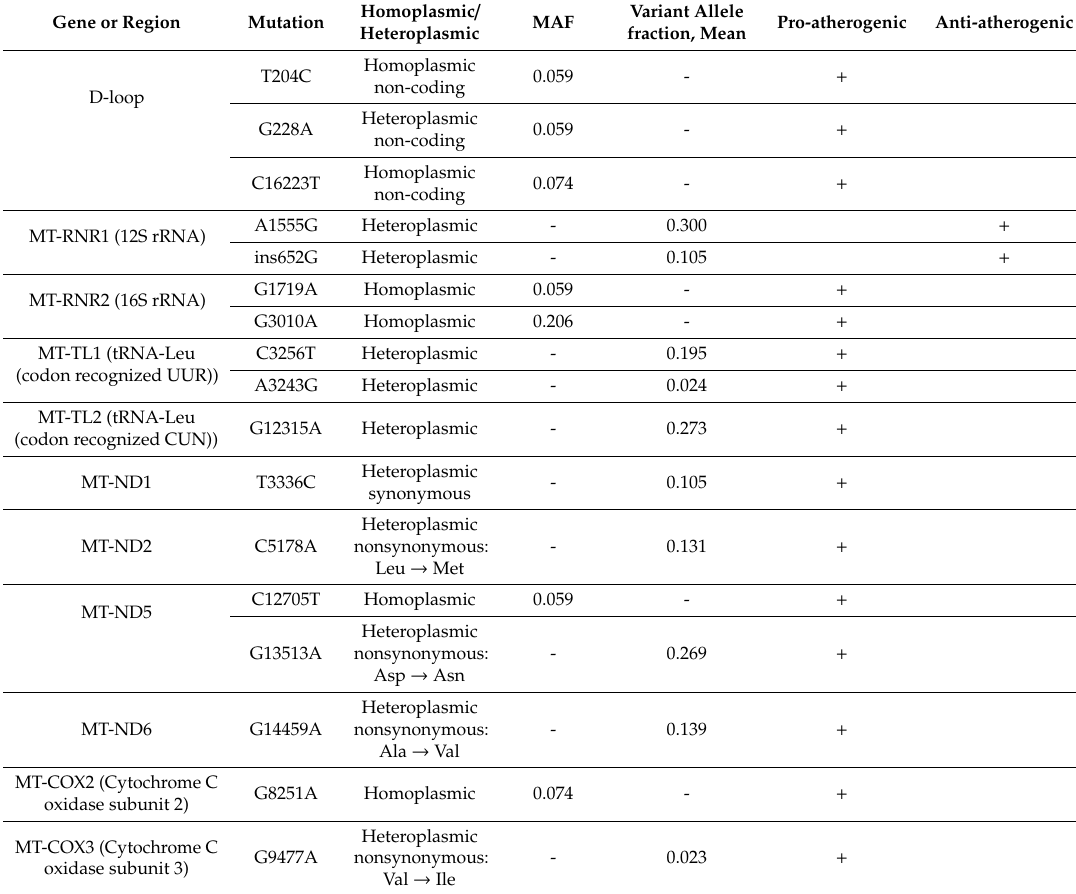
Variant Allele fraction,